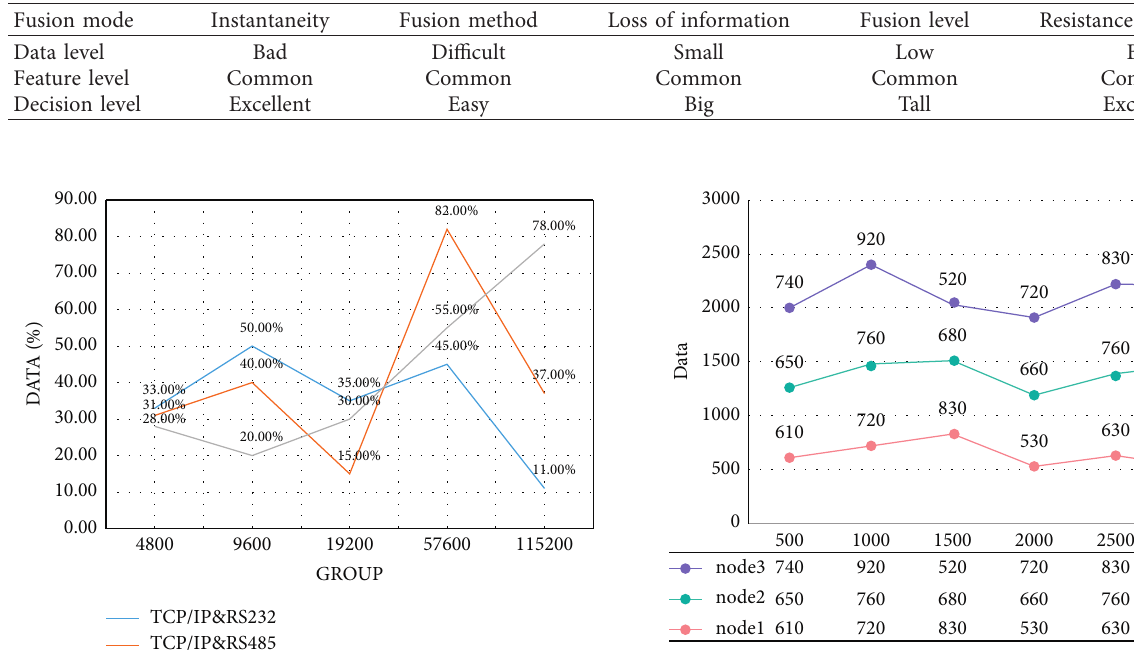
Figure 1: The limit case of the interface by reducing the trans- mission rate.